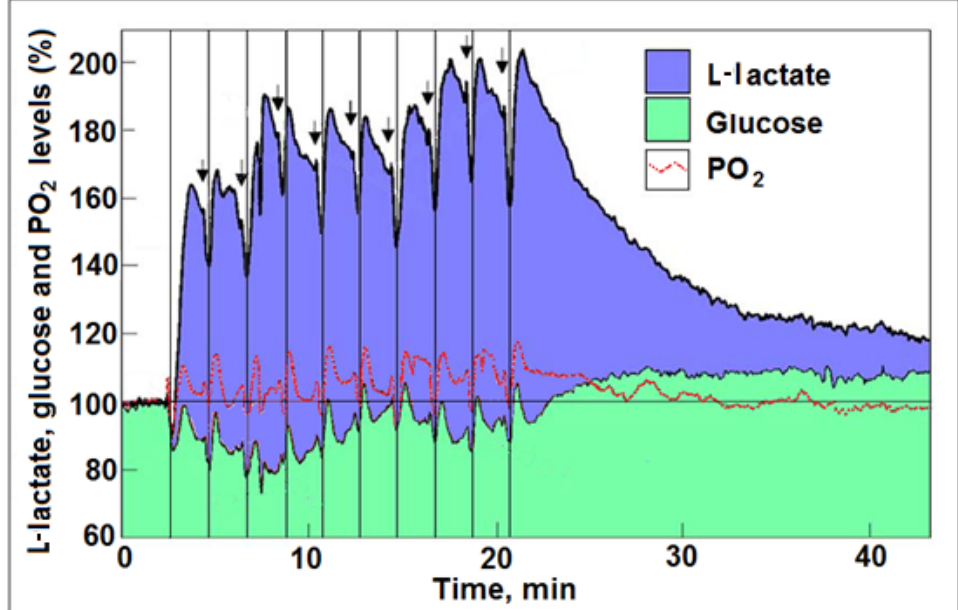
Figure 1. Profiles of time course and dynamic relationships of local extracellular L-lactate, glucose, and PO 2 levels in the rat hippocampal dentate gyrus during a series of 5 s electrical stimulations (arrows) of the perforant pathway at 2 min rest intervals (reproduced from [31]). The changes in the mean concentration of glucose were always in the opposite direction to the changes in mean L-lactate concentration. The vertical lines were drawn to indicate the simultaneous dip in all three analytes in response to each of the electrical stimulations. For additional details, see [31]. This amount of O 2 would oxidize 0.043 mM of L-lactate in the mitochondrial oxphos